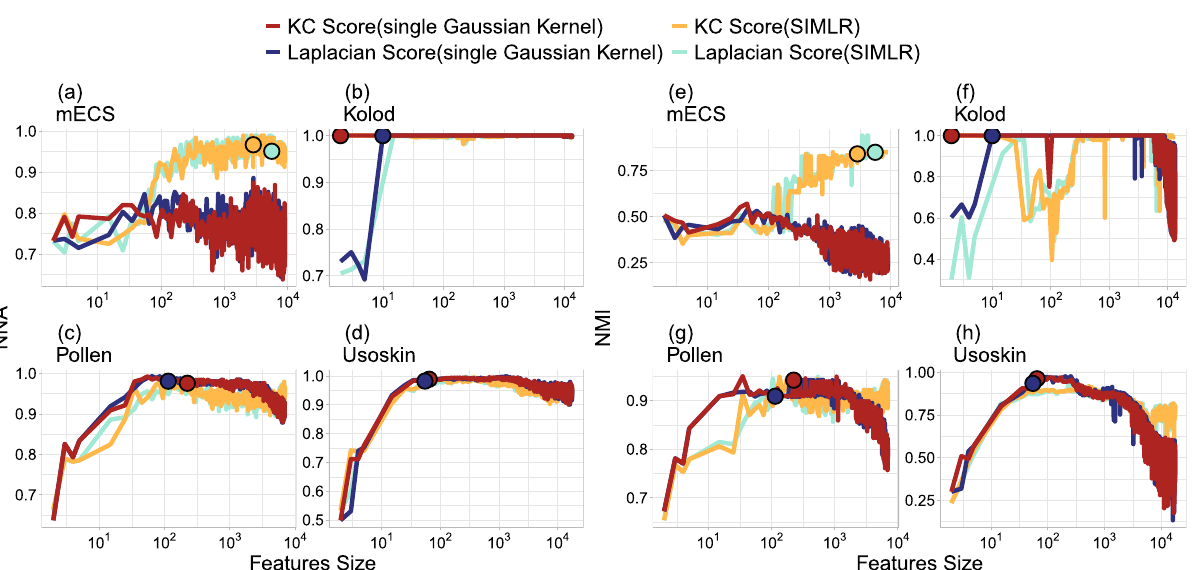
Figure 3. The NNA and NMI curves of Strategy A against different numbers(log scale) of genes based on the KC Score(single Gaussian kernel; SIMLR) versus Laplacian Score(single Gaussian kernel; SIMLR) for the four scRNA-seq datasets, where the circles in each subplot denote the locations of k 2